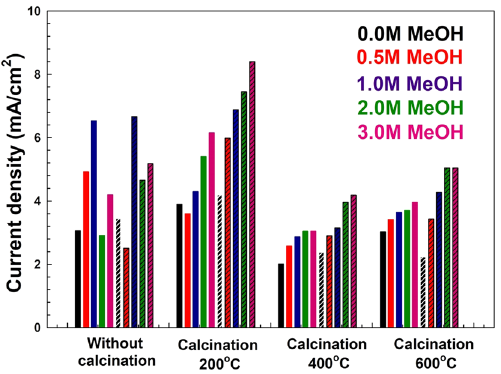
Figure 10. Summary of the current density and fold increases between before adsorption (bulk colour) and after adsorption (fine dashed colour) for all prepared samples.